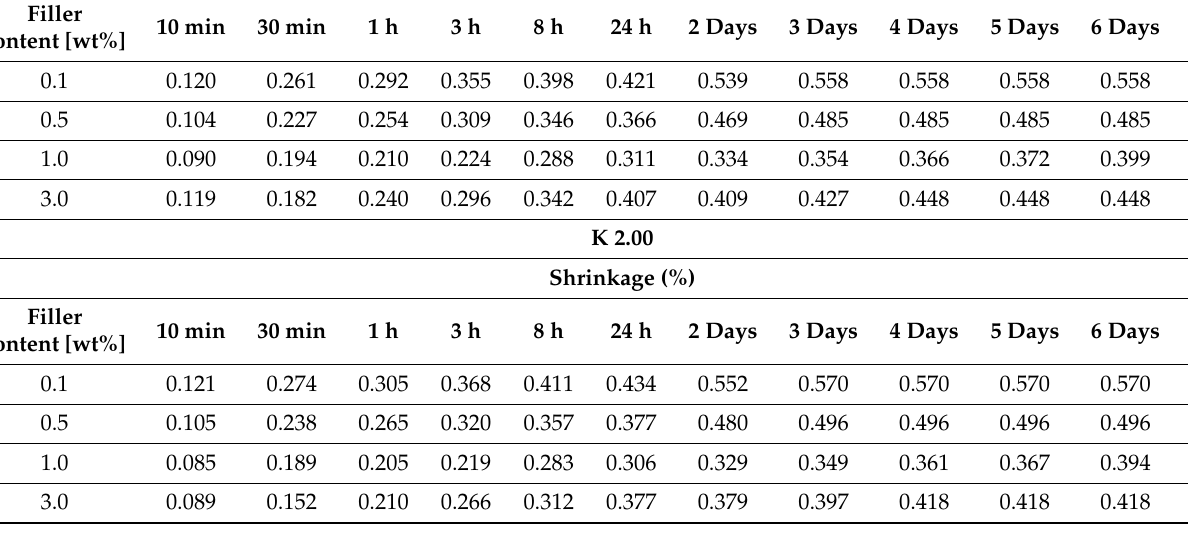
Table 9. Shrinkage of Q2-7355 resin-based pressure-sensitive adhesives with clinoptilolite. K